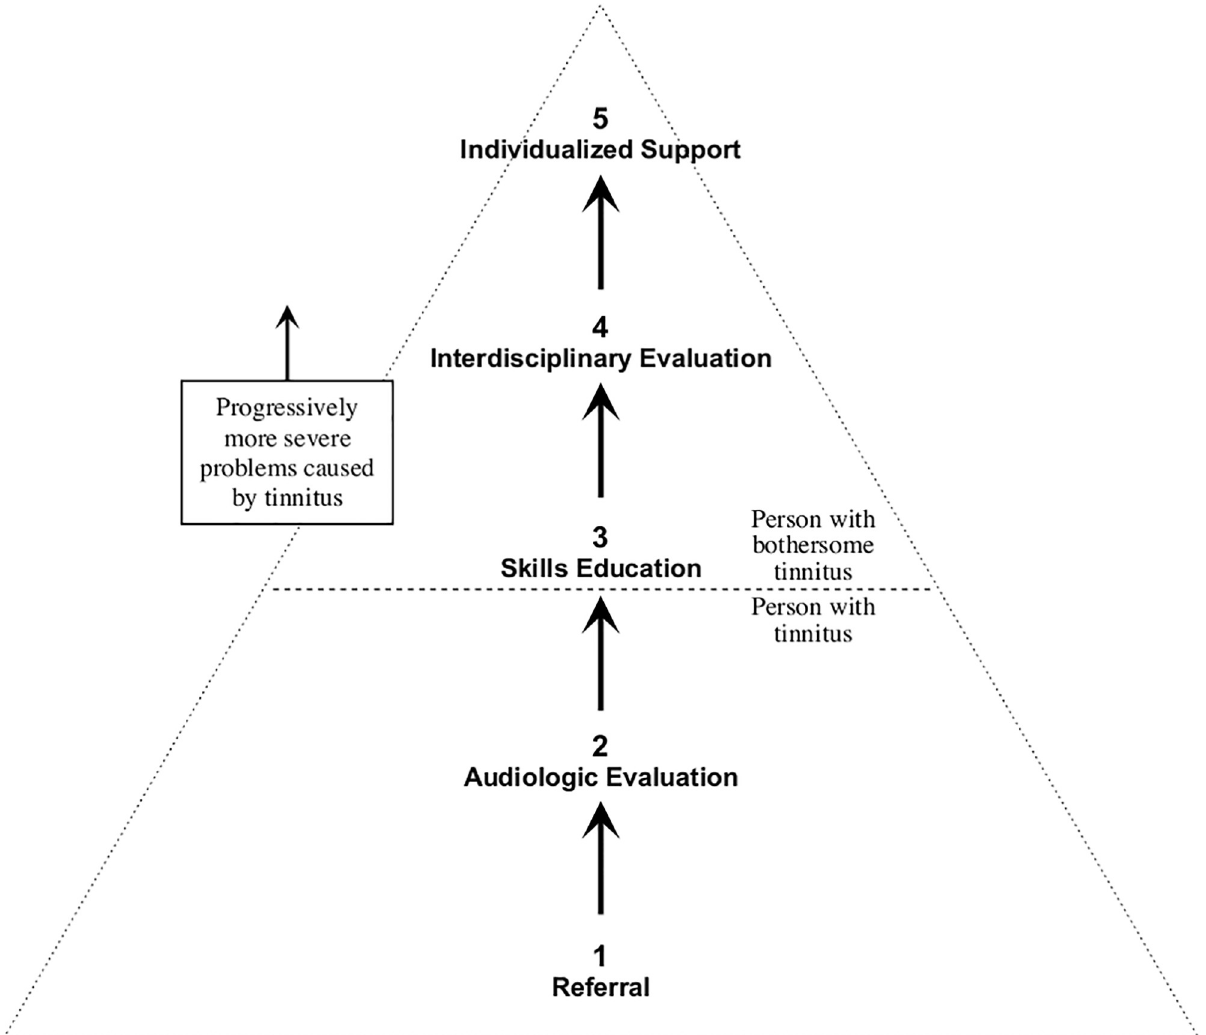
Fig 1. Tinnitus pyramid. The pyramid depicts the entire population of adults with tinnitus. The wide base of the pyramid represents those not particularly bothered by their tinnitus, as the majority of adults with tinnitus fall in this area. Severity increases as you move upwards, with the tip of the pyramid showing the small fraction of individuals who are most severely affected. The five levels of Progressive Tinnitus Management (PTM) are overlaid on the pyramid to reflect the progression from basic to more involved levels of care as needed, based on the severity of the problem with